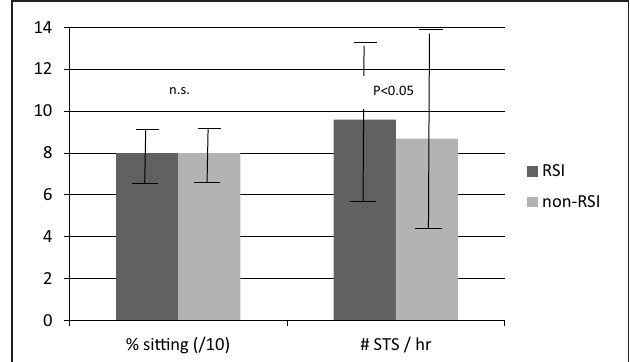
FIGURE 2 | Mean and SD of percentage sitting (for graphical reasons divided by 10) and number of sit-to-stand transitions per hour during working hours in computer workers with and without